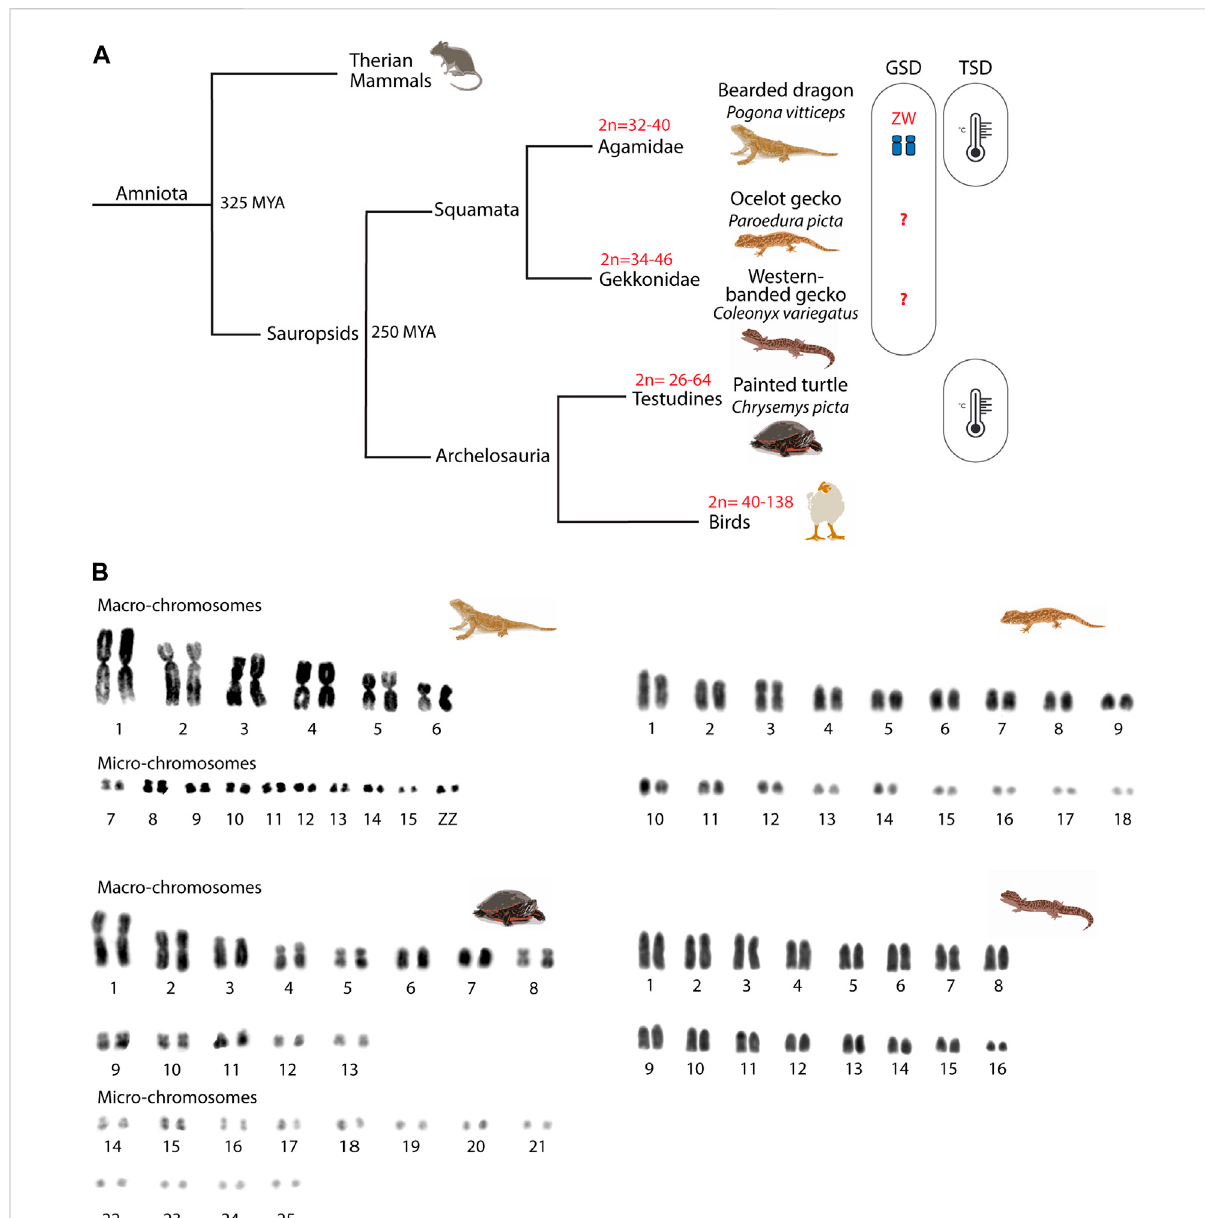
FIGURE 1 Phylogeny of the reptiles included in the study. (A) Phylogenetic relationships of the four reptilian species included in the study. For each phylogenetic branch, variation in diploid numbers and sex determination system are indicated. (B) Mitotic karyotypes of the four studied